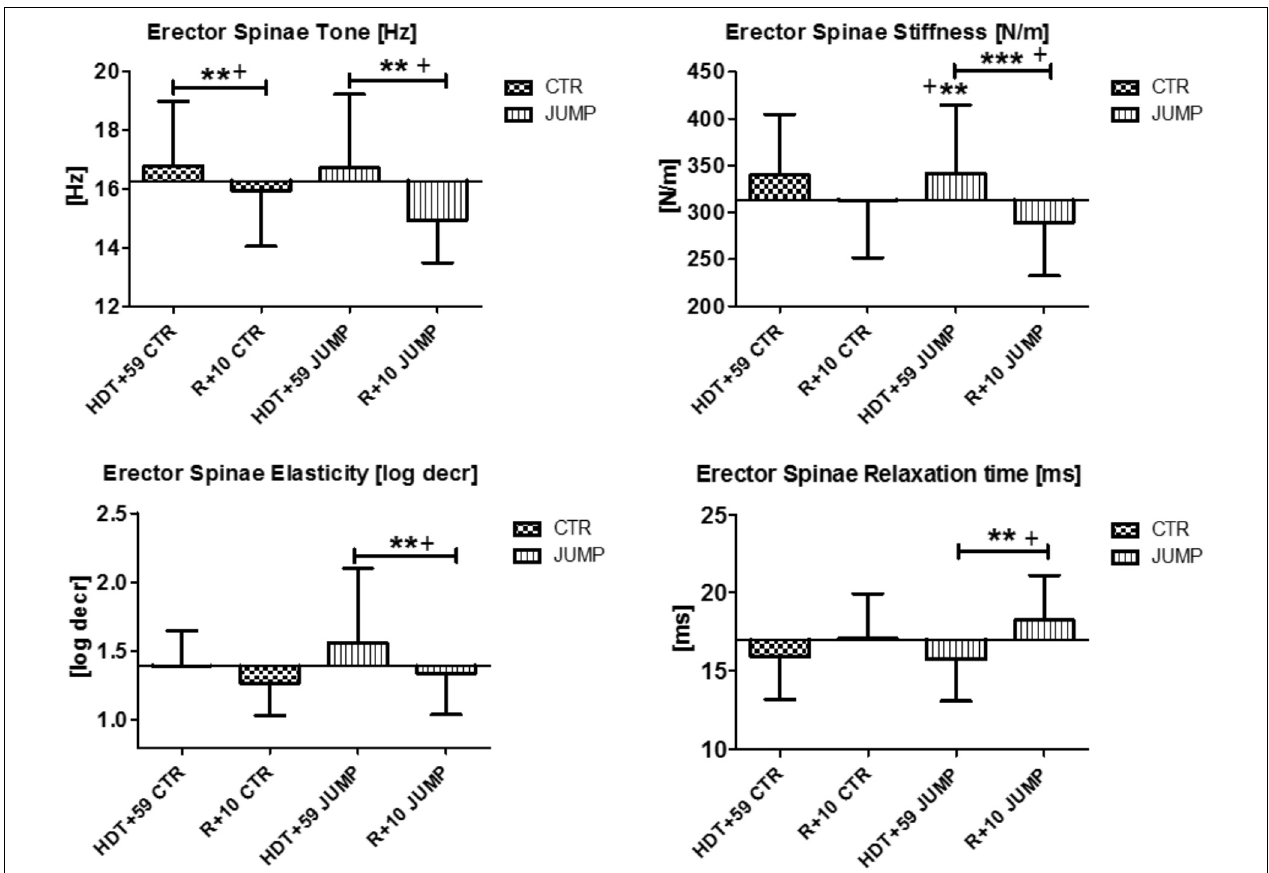
FIGURE 6 | Erector spine (MP11/12). Oscillation signal patterns in RSL bed rest study. P -values (asterisks) refer to each graph. Error bars = SD (standard deviation). ABD = Average baseline data (Tone HDT+1 = 16.27; Stiffness HDT+1 = 313.48; Elasticity HDT+1 = 1.39; Relaxation HDT+1 = 17.0). ∗∗ p < 0.01, ∗∗∗ p < 0.001 ± SD, +Spearman ρ